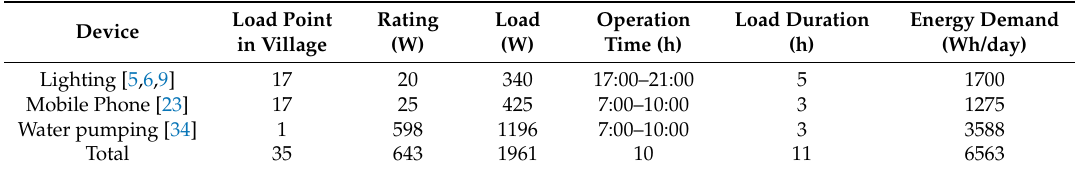
Table 1. Electricity consumption devices and its energy consumption.